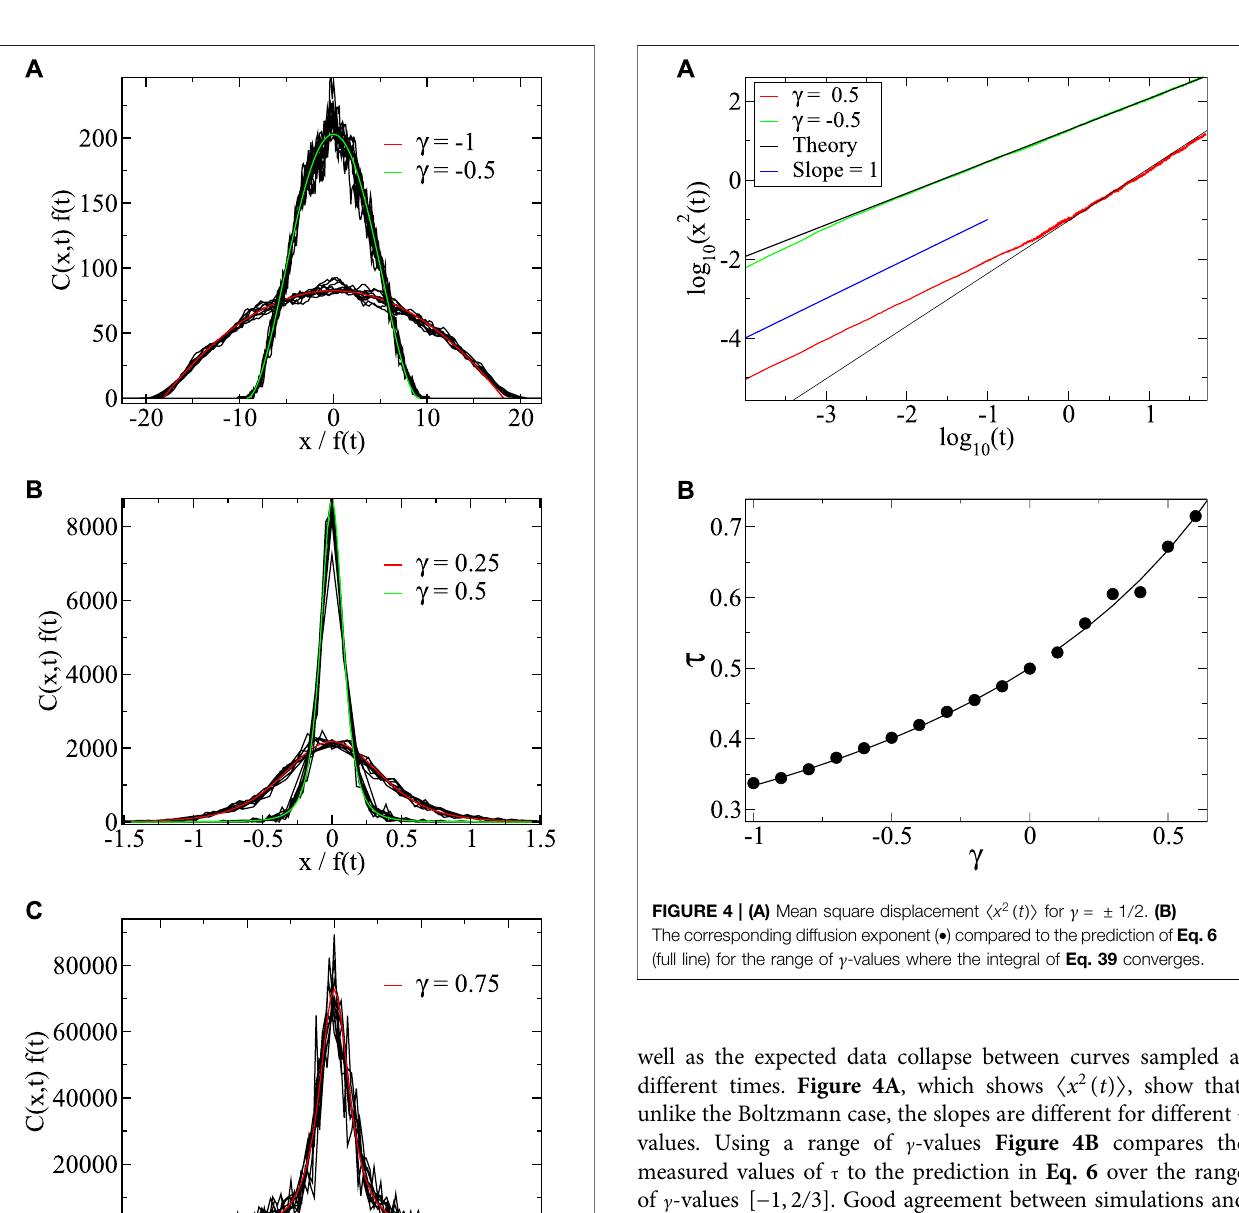
while the the positive γ -values suppress the spreading from these regions while enhancing the spread at small C -values. Figure 3 show simulations compared to the analytic prediction of Eq. 30 . We plot p ( y ) (cid:2) C ( x , t ) / f ( t ) against y (cid:2) x / f ( t ) . The fi gures show a good agreement with theory as